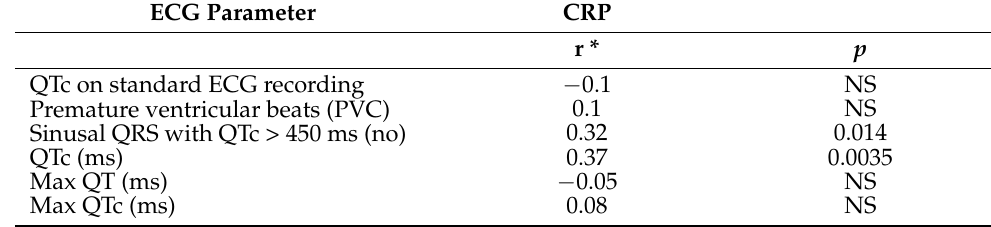
Table 5. Correlations between electrocardiographic parameters and CRP blood